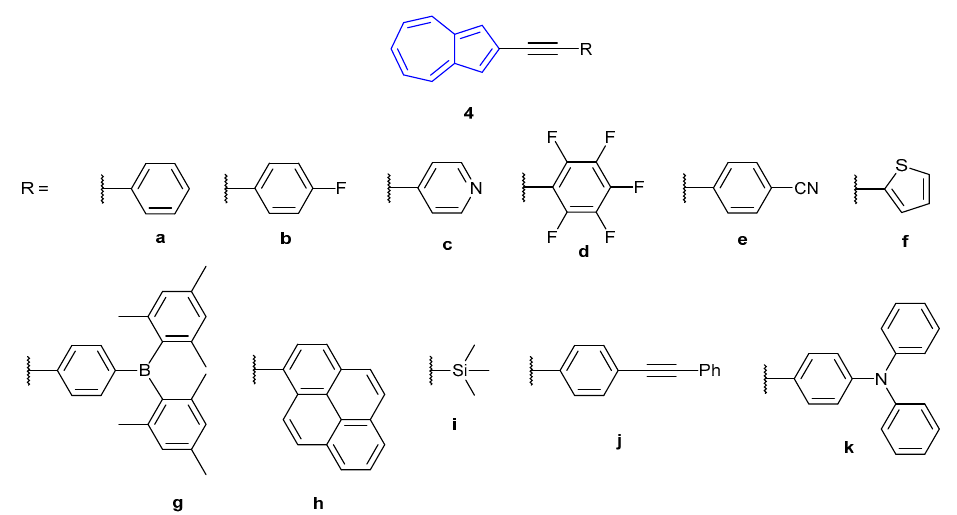
Figure 4. Alkynyl azulene species developed by Venkatesan et al. in 2012 [49] . The following year, Venkatesan et al. published a follow-up article on the stimuli- responsive behaviour of di(phenylethynyl) azulenes species 5a – 5d (Figure 5) [50]. All neutral species showed three distinct absorbance regions: >500 nm (S 0 → S 1 ), 500–370 nm (S 0 → S 2 ) and <370 nm (S 0 → S 3 ), with the most intense absorptions occurring at 409 ( 5d ), 418 ( 5b ), 423 ( 5a ) and 446 nm ( 5d ). The fluorescence emissions of 5a (465 nm) and 5b (432 nm) were found to be very weak, with intensity increasing slightly for 5c (484 nm). Conversely, 5d gave a strong, sharp emission at 416 nm. TF-DFT calculations suggested S 2 → S 0 as the dominant mode of fluorescence in all cases. Upon protonation all species exhibited the previously observed red-shift in absorbances, with maxima at 703, 689, 525 and 490 nm for [5a + H] + to [5b + H] + , respectively. Absorbance intensities of [5c + H] + and [5d + H] + were significantly greater than the other probes, which exhibited relatively low extinction coefficients. Fluorescent emissions of the protonated species also underwent a bathochromic shift relative to their neutral counterparts. Probes [5a + H] + (722 nm) and [5b + H] + (733 nm) remained relatively weakly fluorescent, whilst [5c + H] + (571 nm) and [5d + H] + (537 nm) were strongly fluorescent with the former now emitting with the greatest intensity. The authors commented that the S 2 → S 0 emission was dominant for [5a + H] + , whilst S 1 → S 0 emissions were dominant for the other three probes.